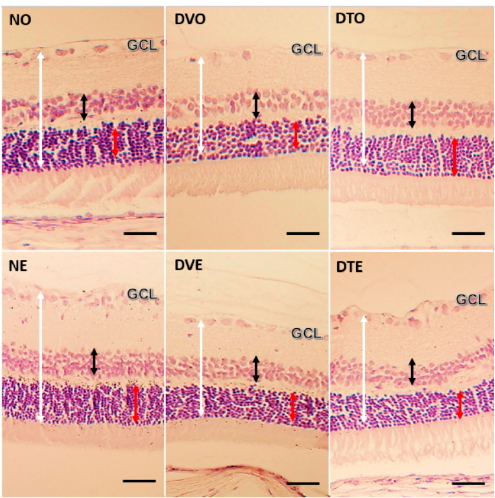
Figure 2. Effect of the tocotrienol-rich fraction (TRF) on blood glucose levels (mmol/L) in rats with streptozotocin (STZ)-induced diabetes. Rats were treated by ( A ) oral and ( B ) topical routes over 12 weeks of the experimental period. NO: Normal rats with oral vehicle treatment, DVO: Diabetic rats with oral vehicle treatment, DTO: Diabetic rats with oral TRF treatment, n = 6,* p < 0.05 versus NO or NE; # p < 0.05 versus DVO. NE: Normal rats with topical vehicle treatment, DVE: Diabetic rats with topical vehicle treatment, DTE: Diabetic rats with topical TRF treatment, n = 6.